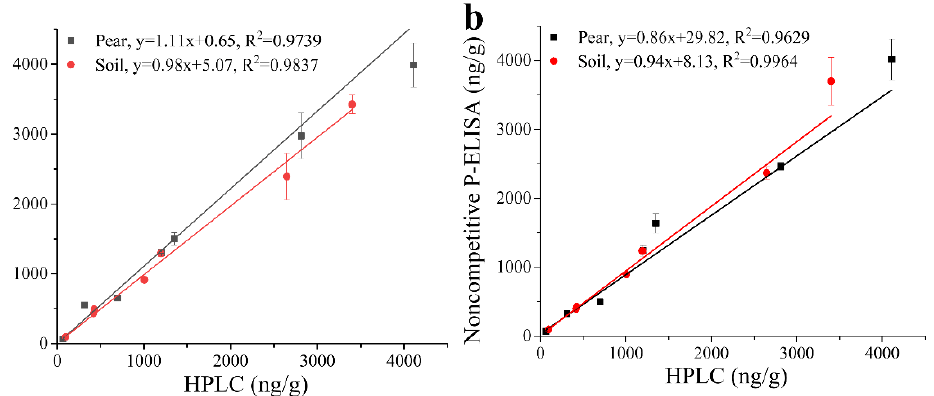
Figure 4. Blind samples tested by P-ELISAs and HPLC. ( a ) Competitive P-ELISA. ( b ) Noncompetitive P-ELISA.